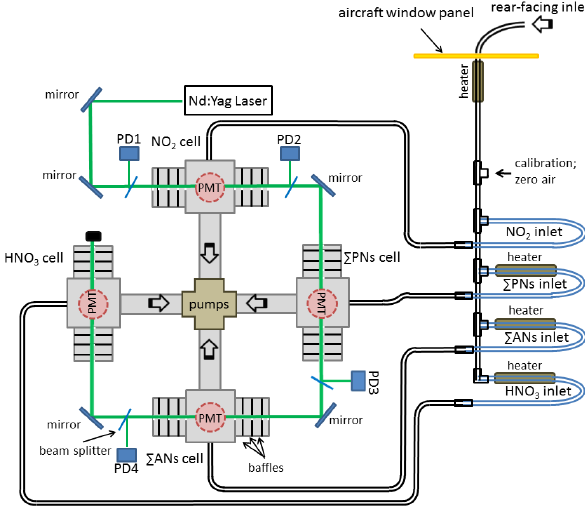
Fig. 1. The optical layout of the TD-LIF with schematics of the in- let system. Note that, to simplify the scheme the tube lengths are Figure 1. The optical layout of the TD-LIF with schematics of the inlet system. Note that, to 2 different here, but in the instrument the length of each of them from simplify the scheme the tube lengths are different here, but in the instrument the length of 3 the inlet to the detection cell is identical to ensure the same resi- each of them from the inlet to the detection cell is identical to ensure the same residence time. 4 dence time. PD1–PD4 are the four photodiodes monitoring the laser PD1-PD4 are the four photodiodes monitoring the laser power. 5